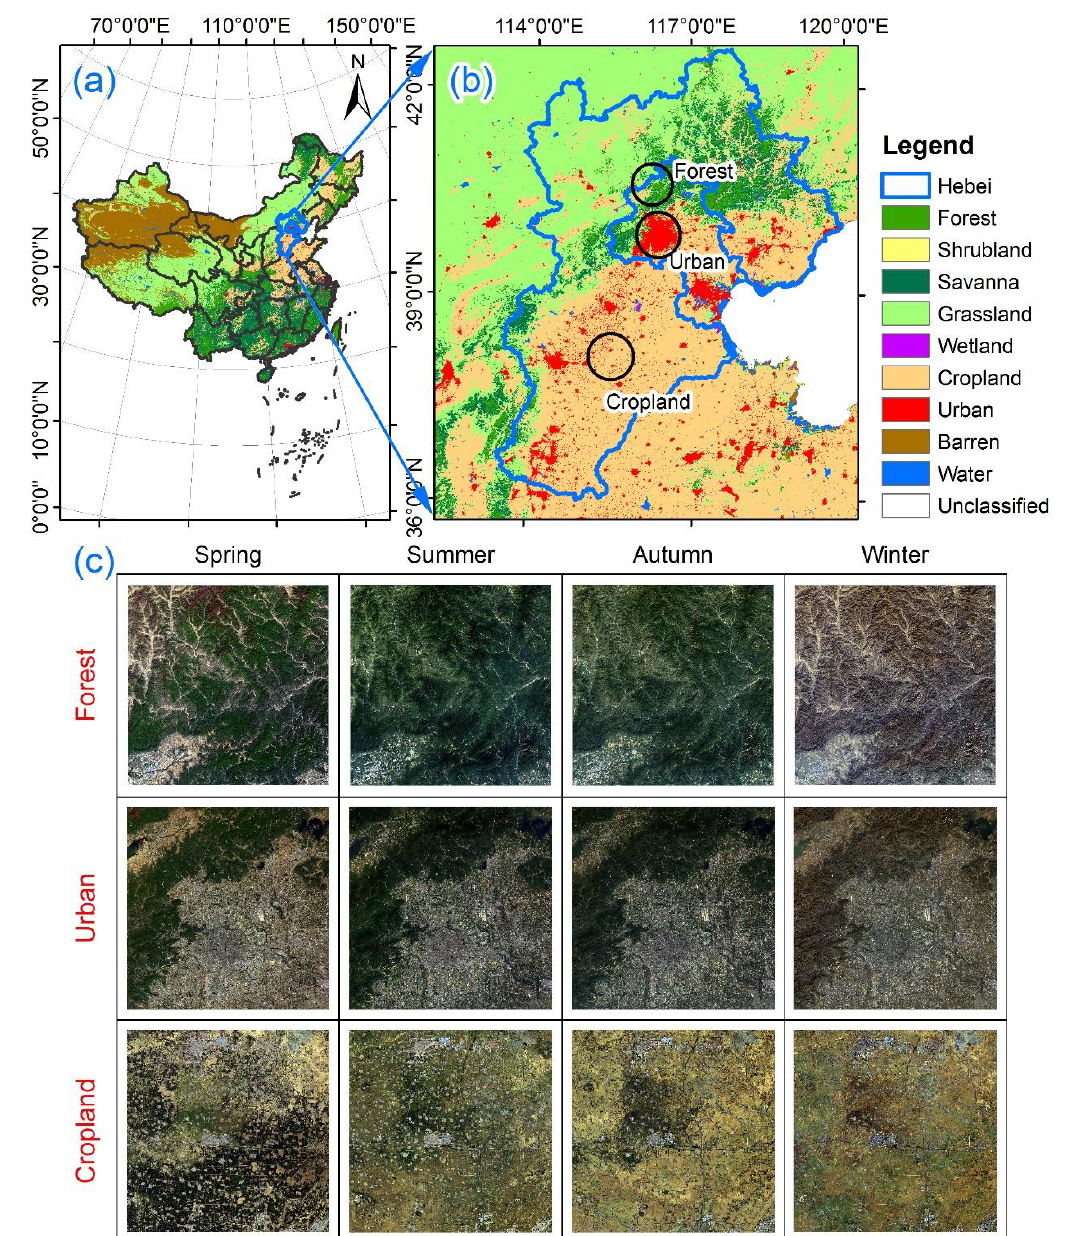
Figure 2. Three different study areas and corresponding satellite data. ( a ) Land cover map of China obtained from the Moderate Resolution Imaging Spectroradiometer (MODIS) yearly land cover product in 2017 (the MODIS image was downloaded from https://ladsweb.modaps.eosdis.nasa.gov/); ( b ) Land cover map of Hebei Province, where the black circles indicate the locations of the three study areas; ( c ) Study areas of different land cover types ranging from spring to winter; the images were obtained from the RGB true-color composite of Landsat 8. Table 1. Description of the Landsat 8 data.